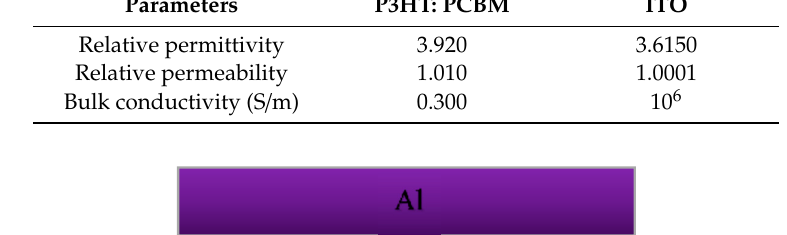
Table 2. The electrical and magnetic parameters of the OSC integrated with the proposed antenna. Parameters